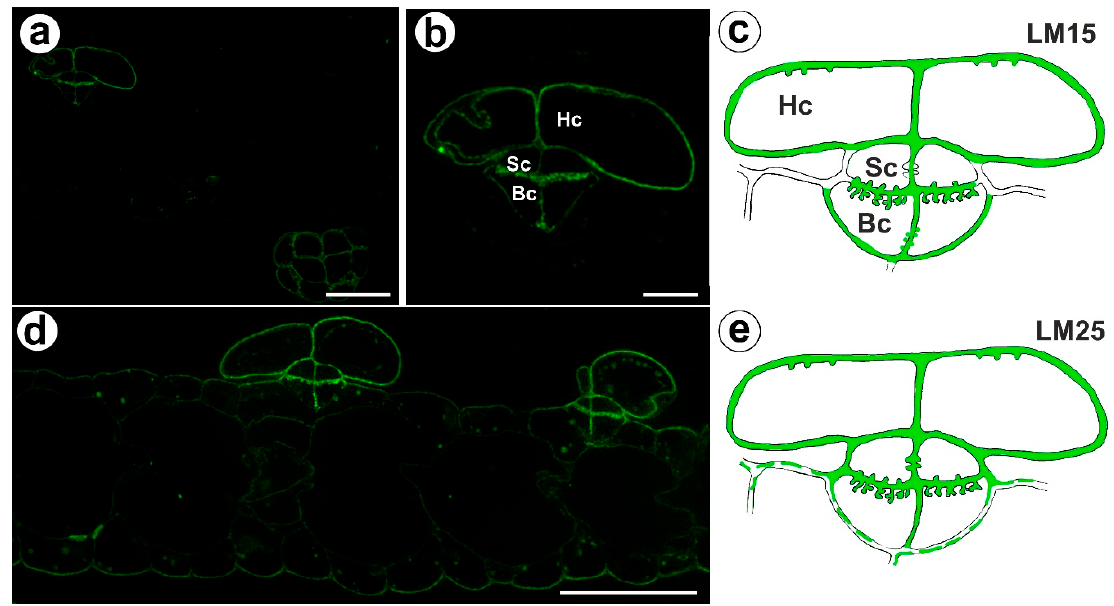
Figure 5. Xyloglucan detected in the bifid trichomes of the Aldrovanda vesiculosa traps. ( a ) Xyloglucan (labeled with LM15) detected in a trichomes and trap wall, bar 25 µm. ( b ) Xyloglucan (labeled with LM15) detected in a trichome, head cell (Hc), stalk cell (Sc), basal cell (Bc), bar 10 µm. ( c ) Schematic occurrence (green) of the xyloglucan (labeled with LM15) detected in a trichome; head cell (Hc), stalk cell (Sc), basal cell (Bc). ( d ) Xyloglucan (labeled with LM25) detected in a trichome, bar 25 µm. ( e ) Schematic occurrence (green) of the xyloglucan (labeled with LM25) detected in a trichome.